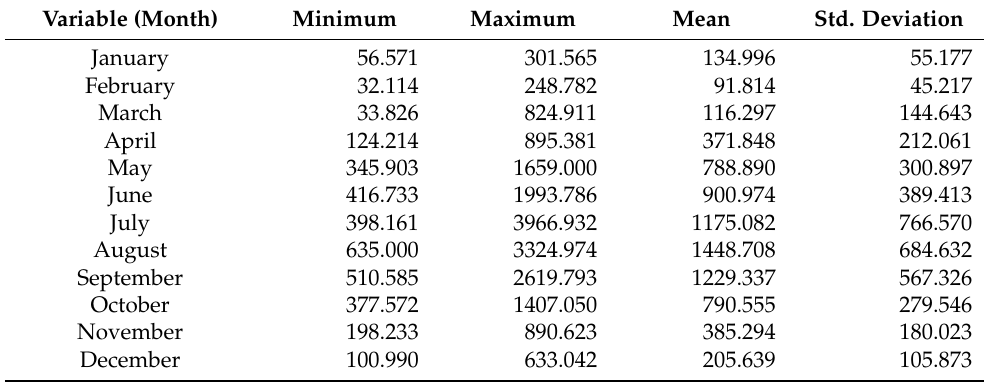
Table 9. Basic statistical characteristics of the Novoselenginsk runoff data